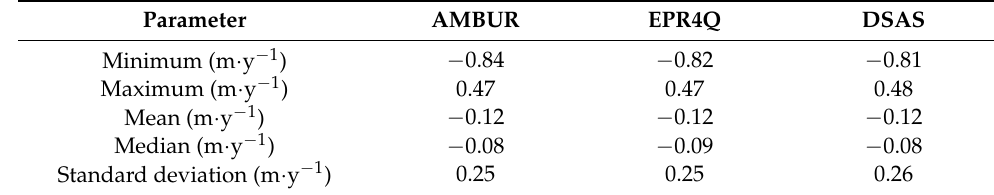
Table 2. Statistical parameters between the different tools applied to the Concepcion shoreline.